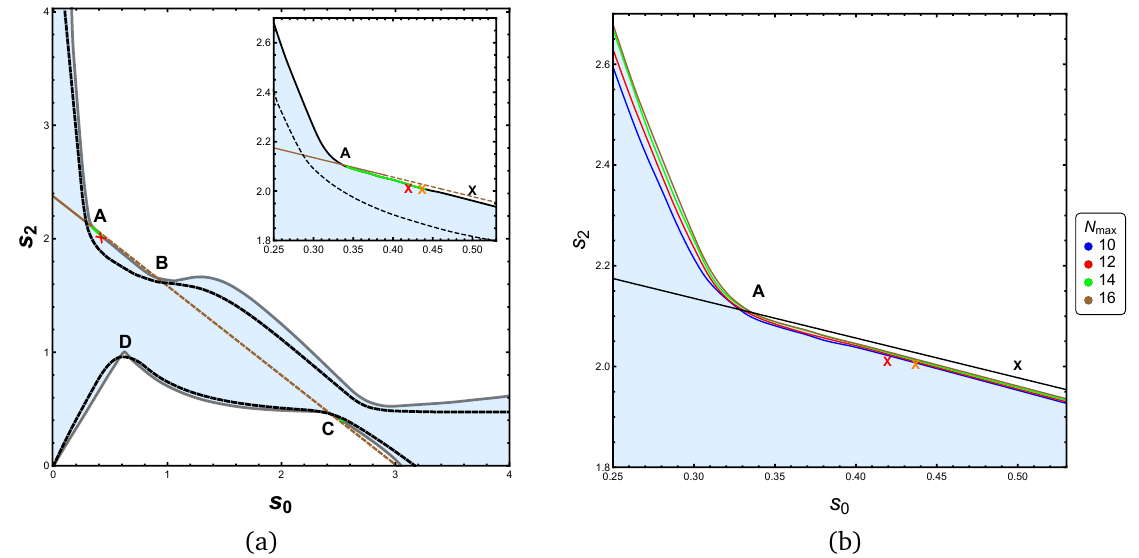
Figure 11: (a) This is the river (black dashed) with all resonances imposed at the mean value of the experimental ranges. The values of resonances determined from the S-matrices of this river serve as our benchmark for the method in appendix B. (b) Behaviour near kink for different N max . The LS line (black) passes very close to the QCD kink. Also note the transition from the tree-level (black cross) to the 1-loop (orange cross) and finally to the 2-loop (red cross) χ PT